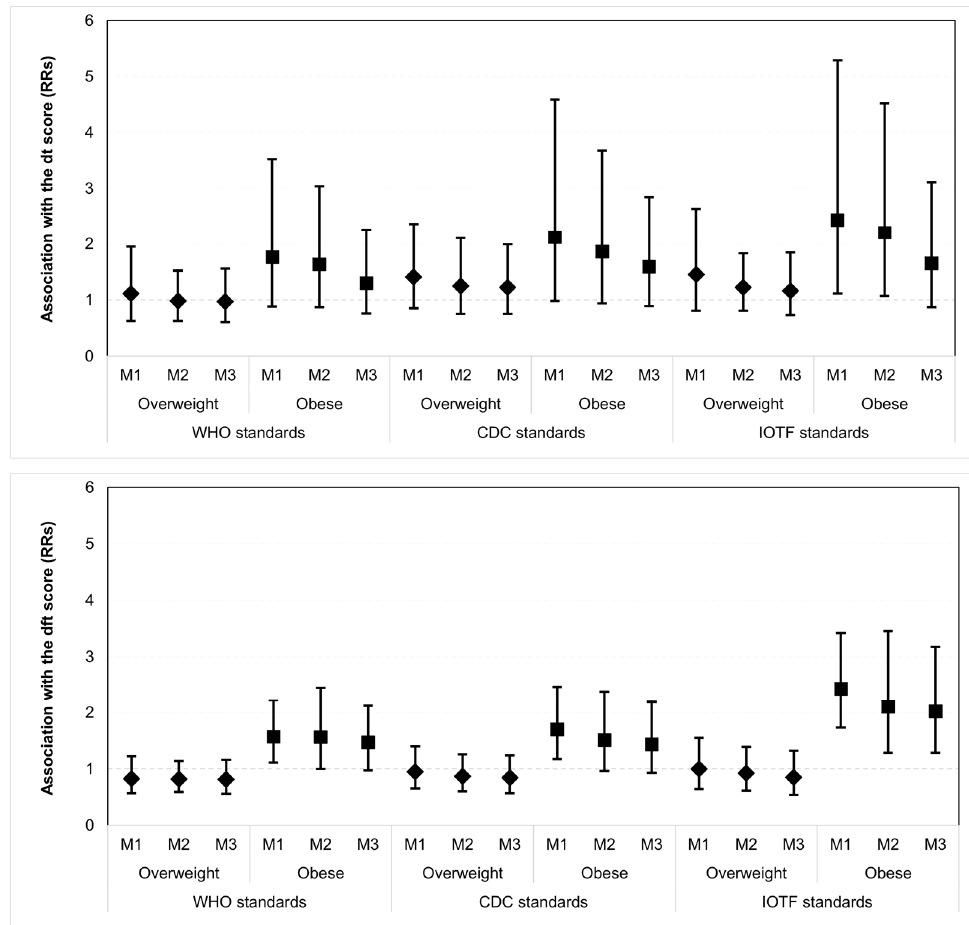
Figure 1. Crude and adjusted estimates (rates ratios, RRs) for the association of overweight and obesity (as defined by three international standards) with the dt and dft scores among 2–5-year-old children ( n = 2275). M1, M2 and M3 correspond to Models 1, 2 and 3 in Table 3. Similar results were obtained when modelling dental caries in terms of having un- treated caries (dt > 0) and caries experience (dft > 0). Obesity was positively associated with greater odds of having caries experience, but not untreated caries, in crude logistic regression models. These associations were fully attenuated after adjustment for demo- graphic factors and remained as such after further adjustment for family SES and child intake of added sugars (Table 4 and Figure